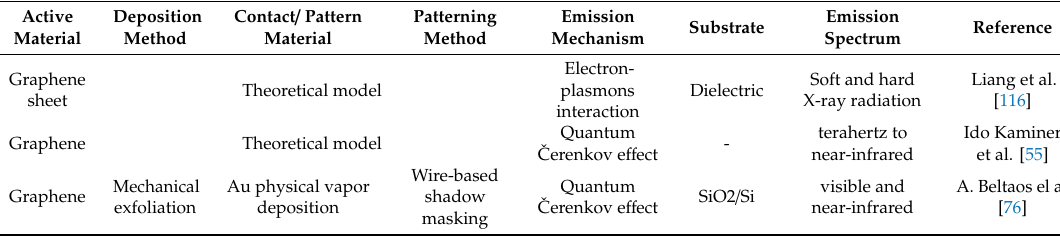
Table 2. The summary of plasmons-assisted emissions from